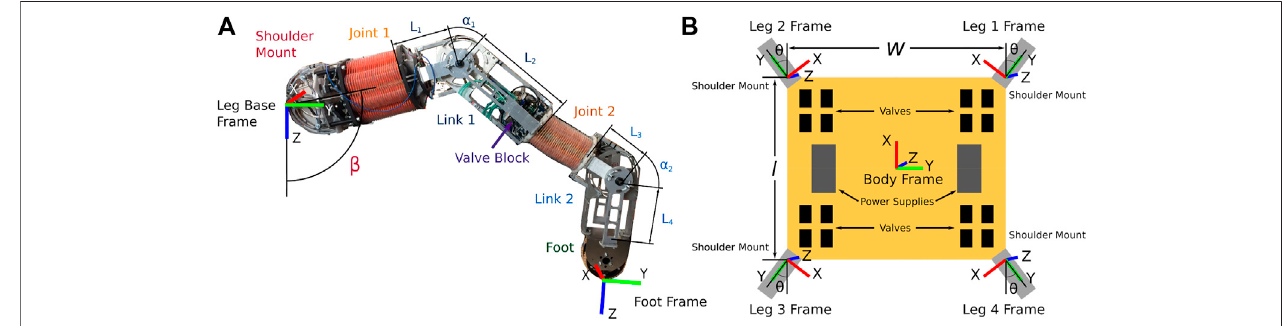
FIGURE 7 | (A) : An illustration of the leg of the robot. Joint 1 is a two-DOF, eight-bellows, pneumatically-actuated, continuum joint. Joint 2 is a two-DoF, four- bellows,pneumatically-actuated,continuumjoint.The valveblockactuates Joint 2.Afoot isattached totheend ofLink2. (B) : Atopviewofthe modelofthebodyofthe quadruped. Valves needed to actuate Joint 1 are included in this model.